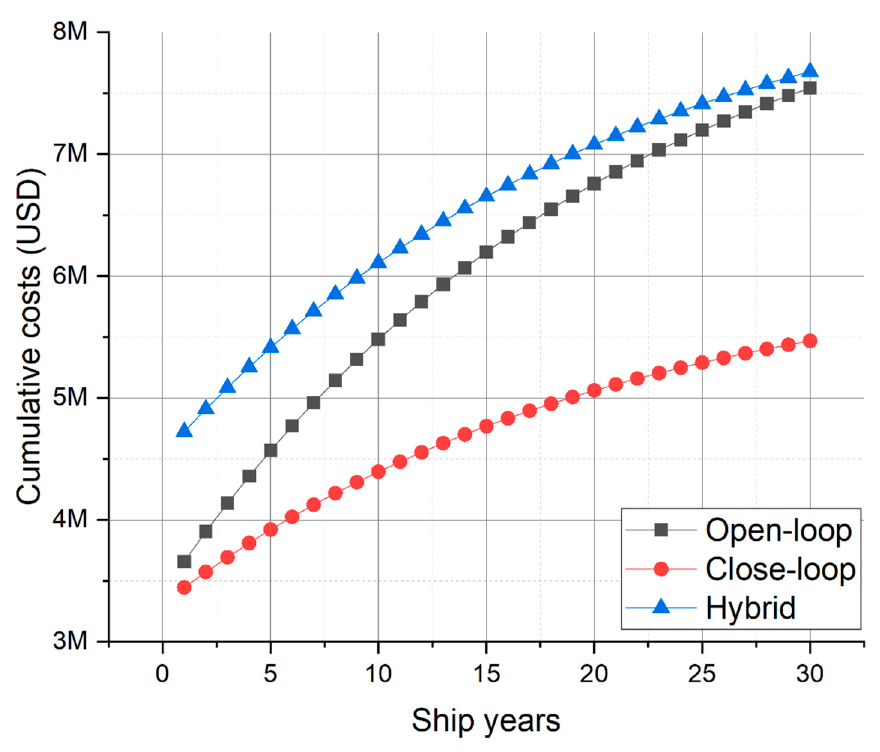
Figure 8. Cumulative costs for economic impact over ship life cycle.